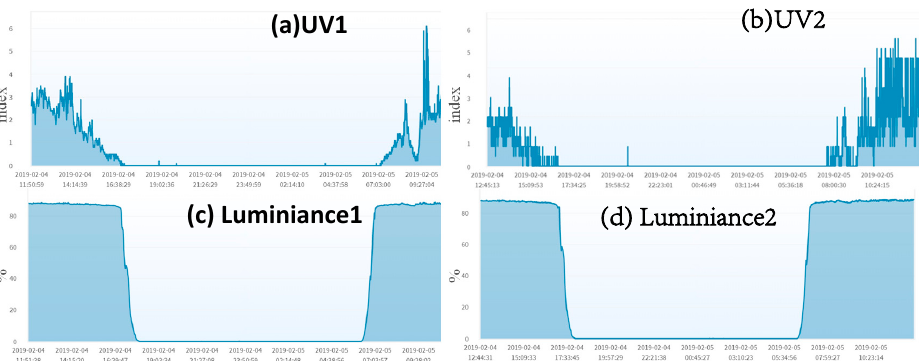
Figure 9. UV and Luminance (Wufeng).